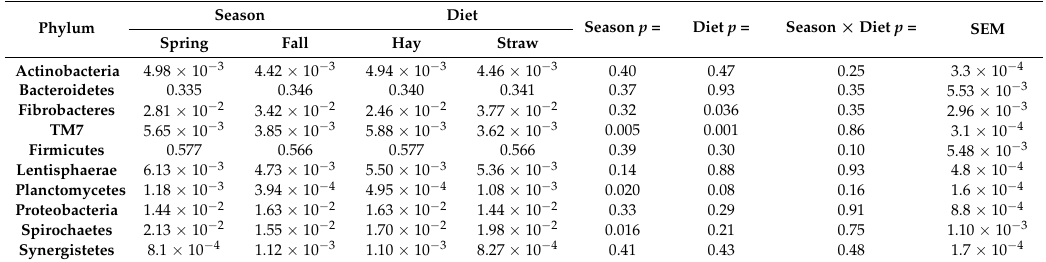
Season p = Diet p = Season × Diet p = SEM